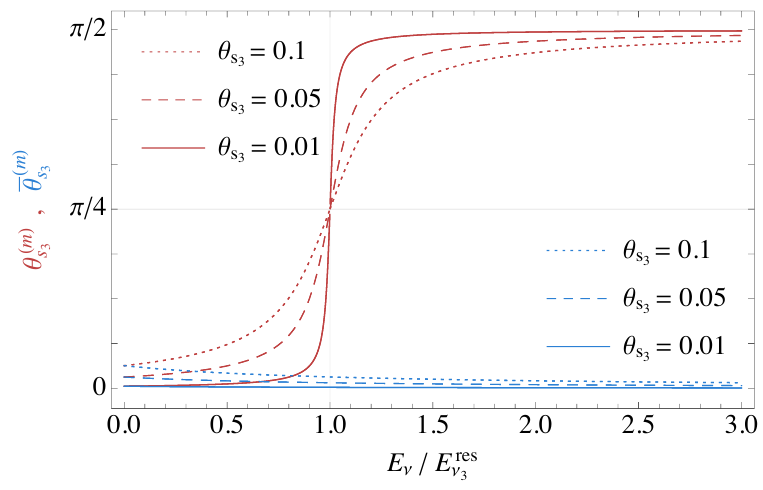
(red curves) and ¯ θ ( m ) (blue curves) between S 3 S 3 for different choices of the vacuum ν 3